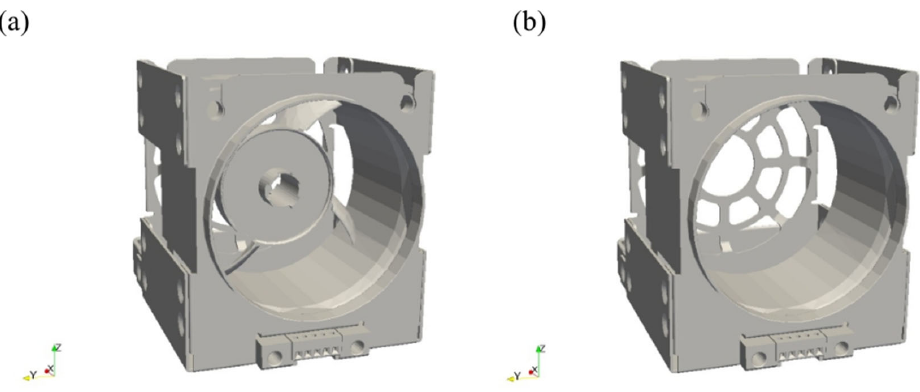
Figure 13. Three-dimensional models of fans for ( a ) inactive and ( b ) active Figure 13. Three ‐ dimensional models of fans for ( a ) inactive and ( b ) active servers.